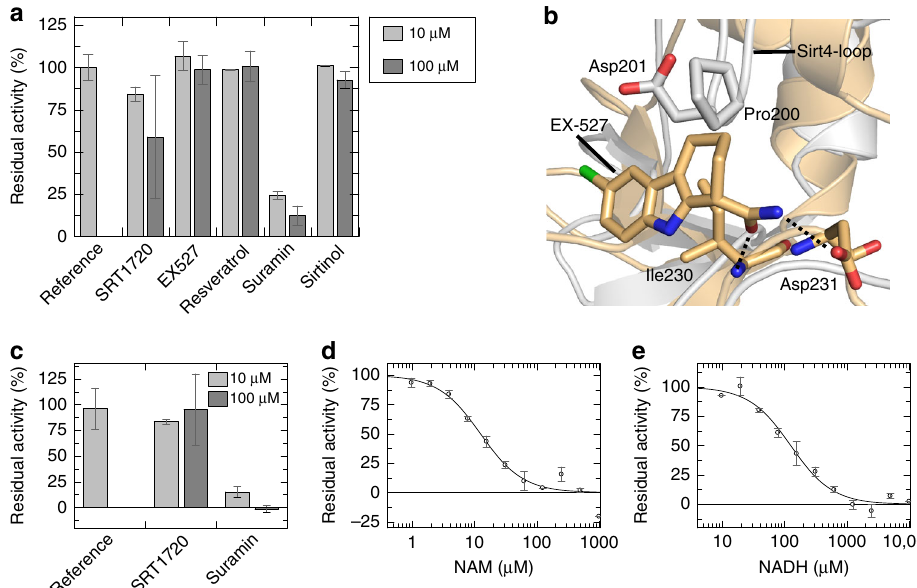
Fig. 4 Sirt4 modulation by physiological metabolites and pharmacological compounds. a Effects of known sirtuin modulators on Sirt4 de-HMG-ylation activity. SRT1720 caused effects in controls, indicating incompatibility with the coupled enzymatic assay. ( n = 2; error bars: s.d.). b C-site regions of xSirt4 (gray) and Sirt3/Ex527 (gold; PDB ID 4BVB), showing that Ex-527 would clash with the Sirt4-loop residue Pro200. Dotted lines: conserved hydrogen bonds for carbamide recognition. c Effects of SRT1720 and suramin on Sirt4 activity in a HMG-FdL assay. ( n = 2; error bars: s.d.). d NAM titration of Sirt4 activity in a HMG-FdL assay. ( n = 2; error bars: s.d.). e NADH titration of Sirt4 activity in a HMG-FdL assay (see Supplementary Fig. 4b for a titration in a MS assay). ( n = 2; error bars: